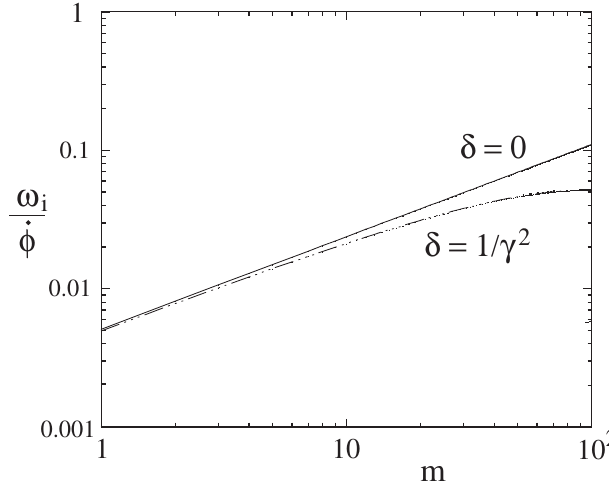
FIG. 3. Growth rates as a function of azimuthal mode m for (cid:5) (cid:2) 0 : 02 , (cid:2) (cid:2) 30 , and various energy spreads. The Bessel functions were retained in order to compute the growth rates in the low m regime